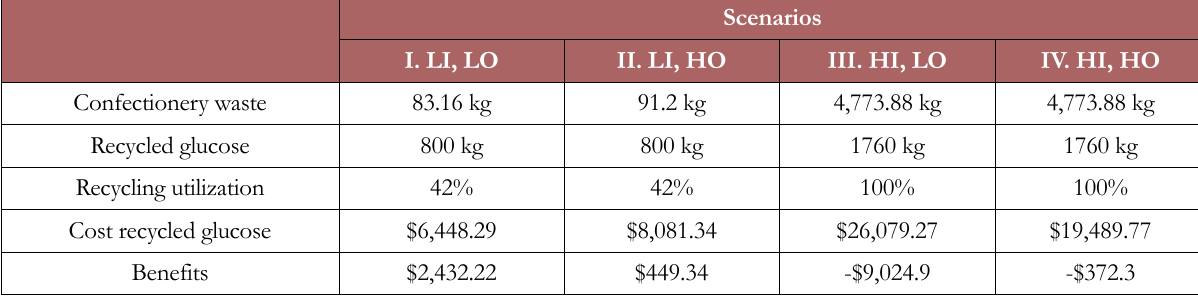
Table 2. Variables observed in the proposed scenarios